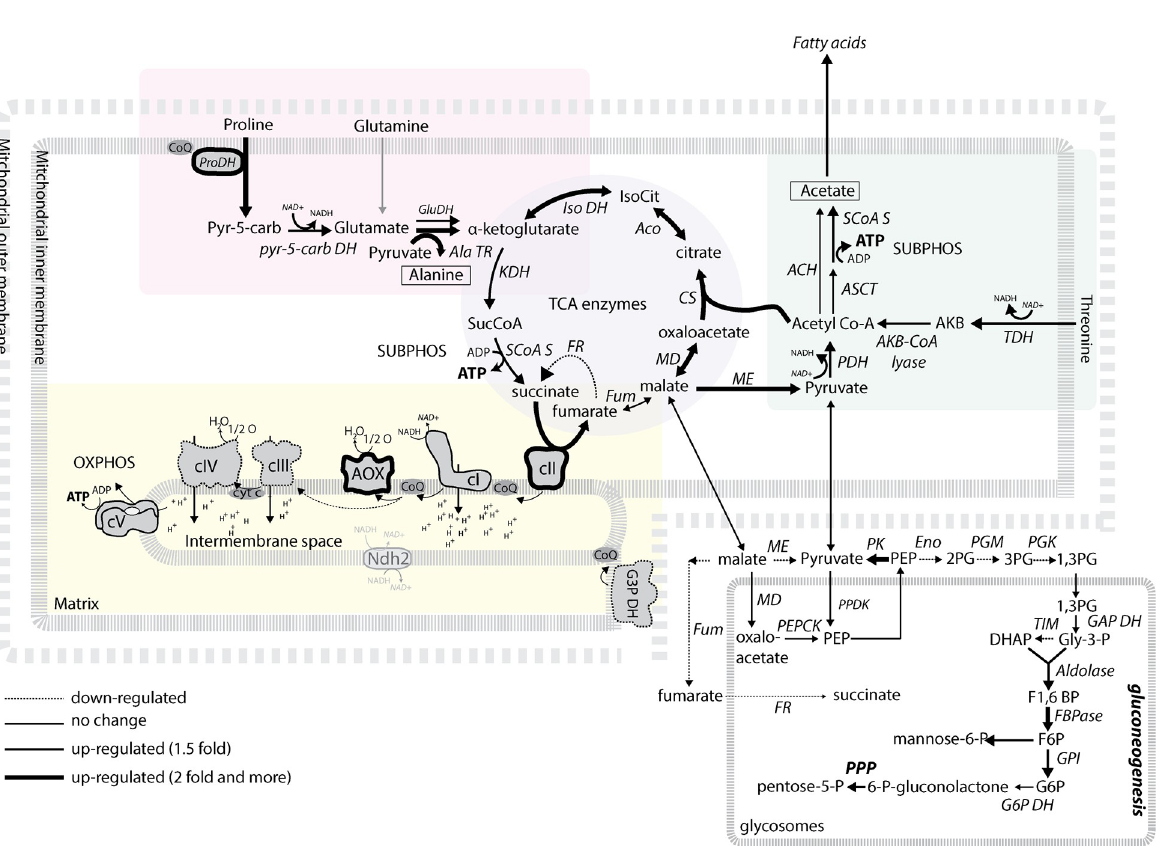
Fig 4. Schematic representation of changes in selected mitochondrial and glycosomal pathways. Enzymatic steps are represented by arrows with different thicknesses, depending on the observed abundance change of the respective protein at day 6 upon RBP6 induction. Dashed lines indicate steps that were down-regulated. Alternative dehydrogenase with unresolved orientation is in gray. The metabolic end products are highlighted by black lines. ACH, acetyl-CoA thioesterase; Aco, aconitase; AKB–CoA lyase, 2-amino-3-ketobutyrate Coenzyme A lyase; Ala TR, alanine aminotransferase; AOX, alternative oxidase; ASCT, acetate:succinate CoA-transferase; cI, complex I, NADH:ubiquinone oxidoreductase; cII, succinate dehydrogenase; cIII, complex III, ubiquinol:cytochrome c reductase; cIV, complex IV, cytochrome c oxidase; cV, F o F 1 -ATP synthase; CS, citrate synthase; DHAP, dihydroxyacetone phosphate; Eno, enolase; FBPase, fructose 1,6-bisphosphatase; FR, fumarate reductase; Fum, fumarase; F1,6 BP, fructose 1,6 bisphosphate; F6P, fructose-6-phosphate; GAPDH, glyceraldehyde-3-phosphate dehydrogenase; Glu DH, glutamate dehydrogenase; Gly-3-P, glycerol-3-phosphate; GPI, glucose-6-phosphate isomerase; G3P DH, glycerol-3-phosphate dehydrogenase; G6P, glucose-6-phosphate; G6P DH, glucose-6-phosphate dehydrogenase; Iso DH, isocitrate dehydrogenase; IsoCit, isocitrate; KDH, α - ketoglutarate dehydrogenase; MD, malate dehydrogenase; ME, malic enzyme; OXPHOS, oxidative phosphorylation; PDH, pyruvate dehydrogenase; PEP, phosphoenolpyruvate; PEPCK, phosphoenolpyruvate carboxykinase; PG, phosphoglycerate; PGK, phosphoglycerate kinase; PGM, phosphoglycerate mutase; PK, pyruvate kinase; PPDK, pyruvate, phosphate dikinase; PPP, pentose phosphate pathway; Pro DH, proline dehydrogenase; pyr-5-carb, pyrroline-2-carboxylate; pyr-5-carb DH, pyrroline-5 carboxylate dehydrogenase; RBP6, RNA binding protein 6; SUBPHOS, substrate phosphorylation; SCoAS, succinyl-Coenzyme A synthetase; SucCoA, succinyl-CoA; TDH, threonine dehydrogenase; TIM, triose-phosphate